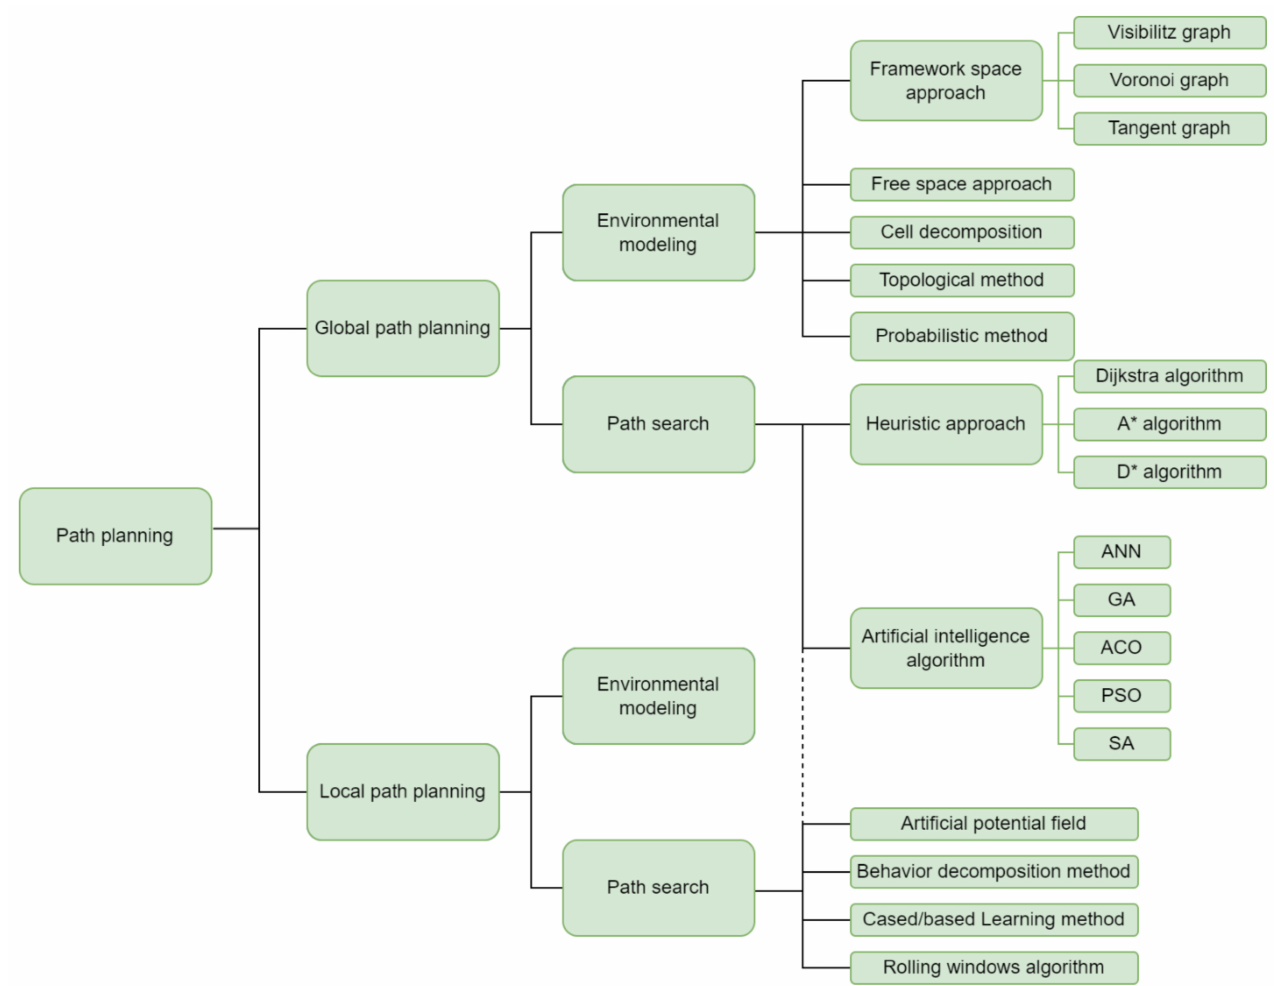
Figure 2. Methods of path